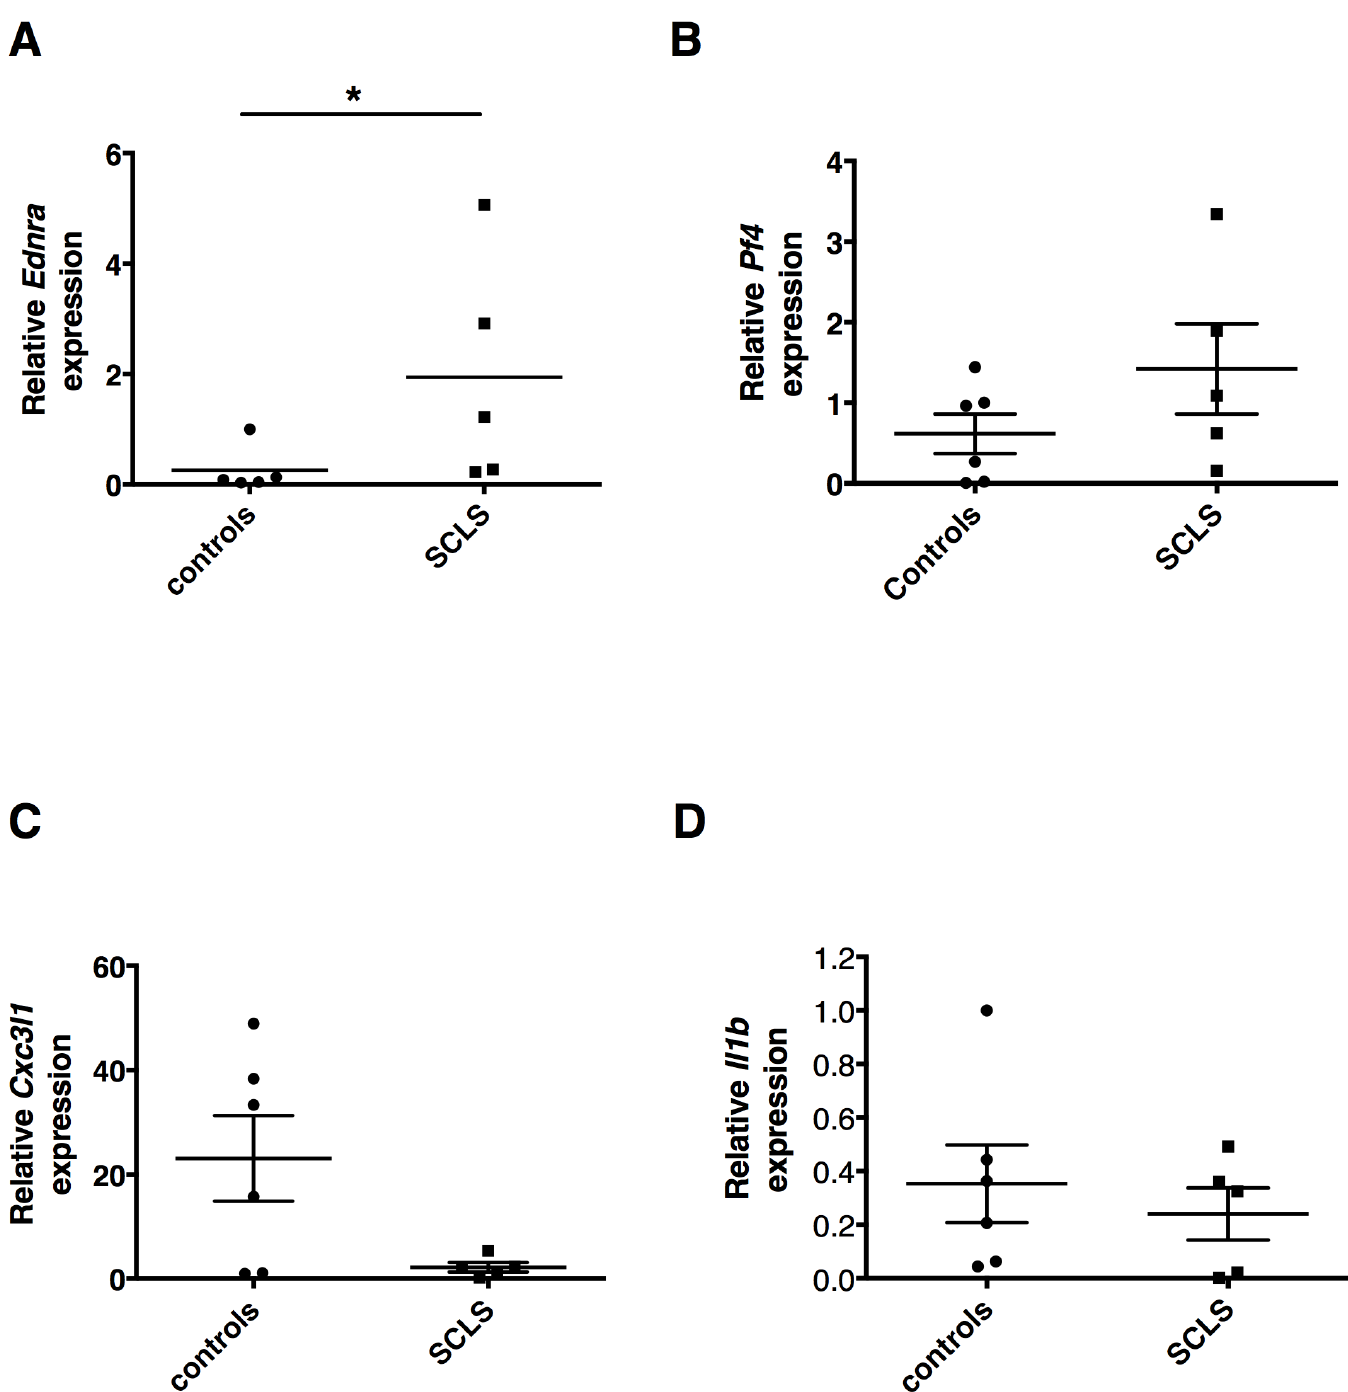
Fig 1. Gene expression in BOEC from individual subjects. (A-D) Relative expression of Ednra , Cx3cl1 , Pf4 , and Il1b in individual subjects as determined by real-time qPCR. * p = 0.03, Mann-Whitney test.